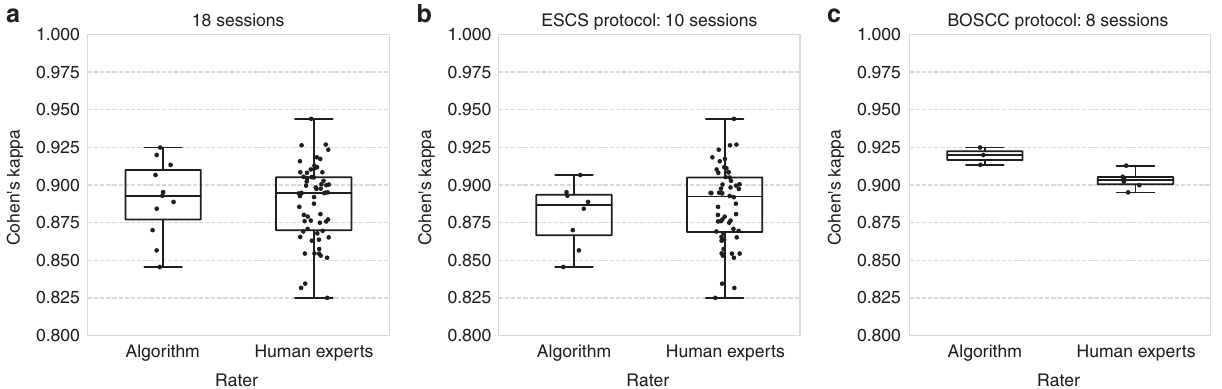
Fig. 3 Pairwise Cohen ’ s kappa distributions among all human pairs and human – algorithm pairs, represented as box plot. a 18 validation sessions, b ESCS, c BOSCC. Generally, kappa scores above 0.8 are considered an almost perfect agreement. On all sessions annotated by ten human experts, agreements among humans and agreements between each human and algorithm are similar in terms of